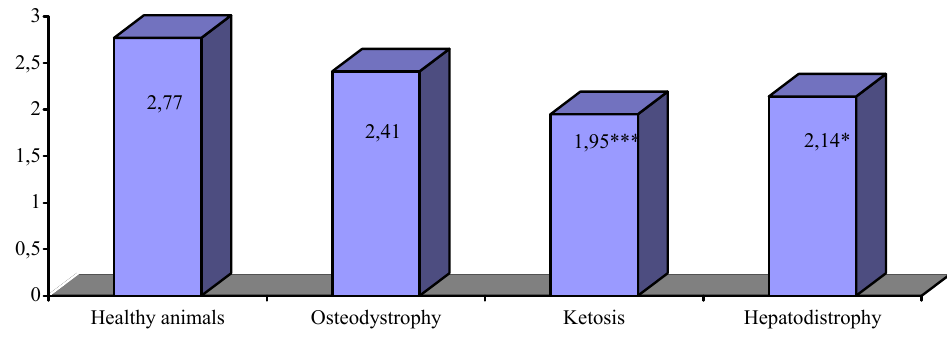
Fig. 1. Glucose content in blood serum of cows (mmol/l)